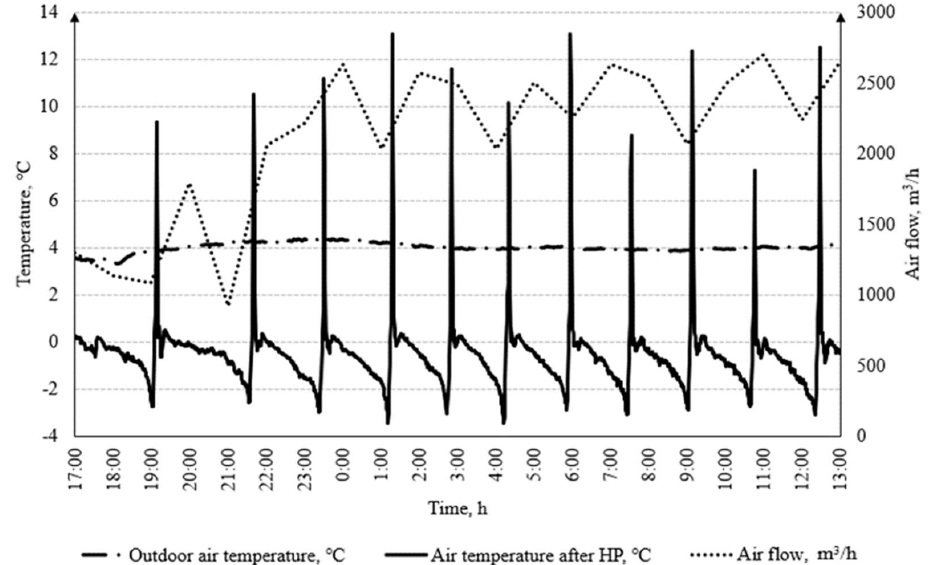
Figure 4. A comparison of the ambient air flow rate with the air flow temperature after the evaporator heat exchanger and the air flow rate through it (11–12 November 2020).